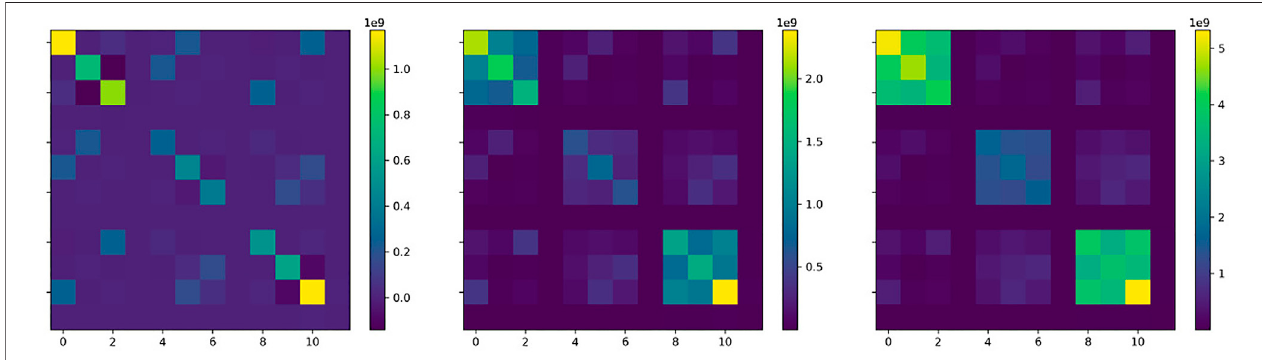
FIGURE 2 | Metric tensors shown here for 12 parameter af fi ne transformations. Left: origin at the center, middle: origin half way, right: origin at the corner.